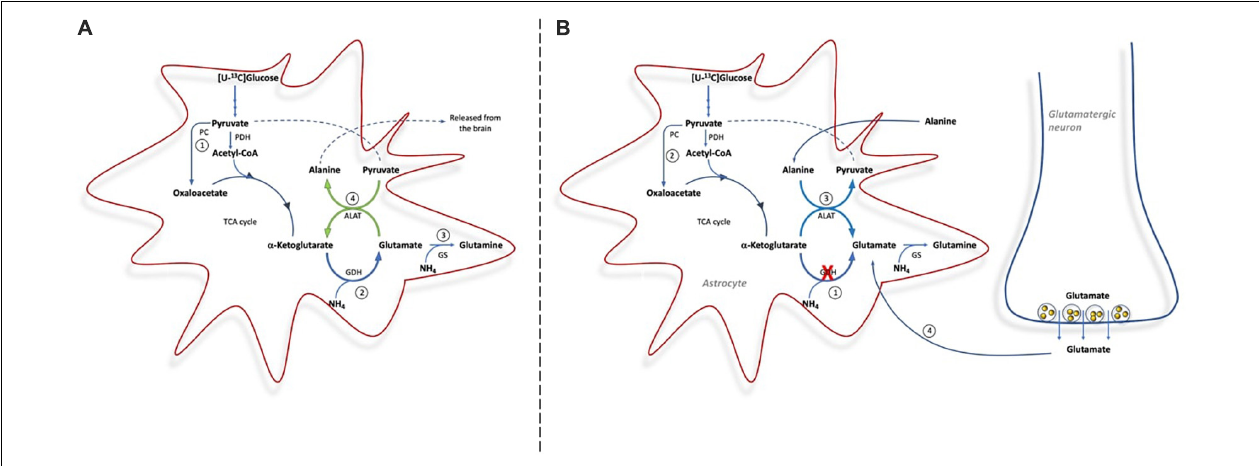
FIGURE 5 | Cartoon demonstrating the metabolic pathways involved in ammonia detoxification in brain slices from Glud1 lox / lox mice (A) and from CNS- Glud1 − / − mice (B) . (A) : In brain slices from Glud1 lox / lox mice glucose enters the TCA cycle vi a PDH and PC for de novo synthesis of glutamate (1), GDH is important for ammonia fixation and de novo synthesis of glutamate (2), glutamate is used as precursor for glutamine synthesis in astrocytes (3), and The concerted action of GDH and ALAT provides a mechanism for continuous fixation and disposal of ammonia as alanine is released from the brain (4). (B) : In brain slices from CNS- Glud1 − / − mice, the lack of GDH impairs the possibility for de novo synthesis of glutamate (1), which results in less glucose entering the TCA via PC (2), and the direction of ALAT is reversed in order to sustain glutamate synthesis that can serve as precursor for glutamine synthesis (3). In addition, neurotransmitter glutamate cleared from the synapse by astrocytes is used for glutamine synthesis